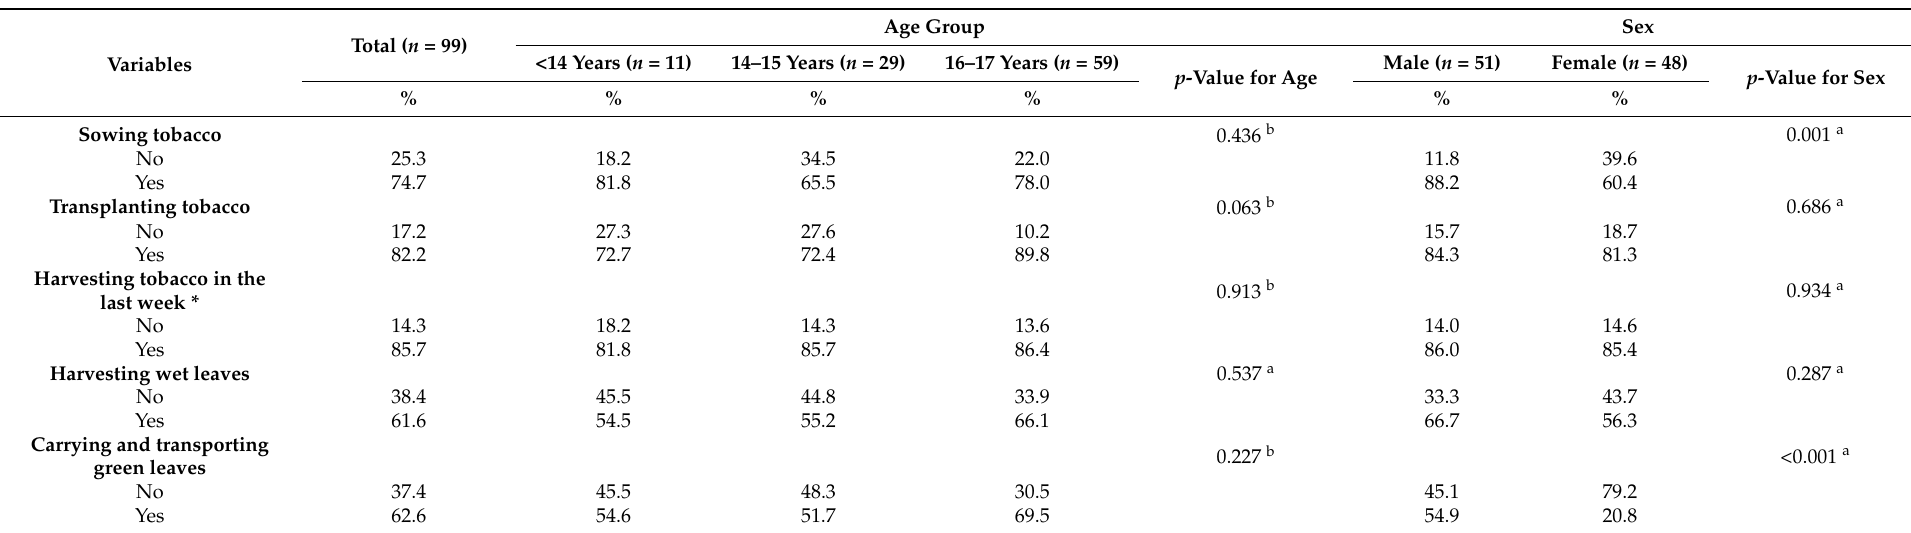
Table 3. Tobacco worker activities and workloads, stratified by age group and sex. S ã o Lourenço do Sul, Rio Grande do Sul, Brazil, 2011. ( n =